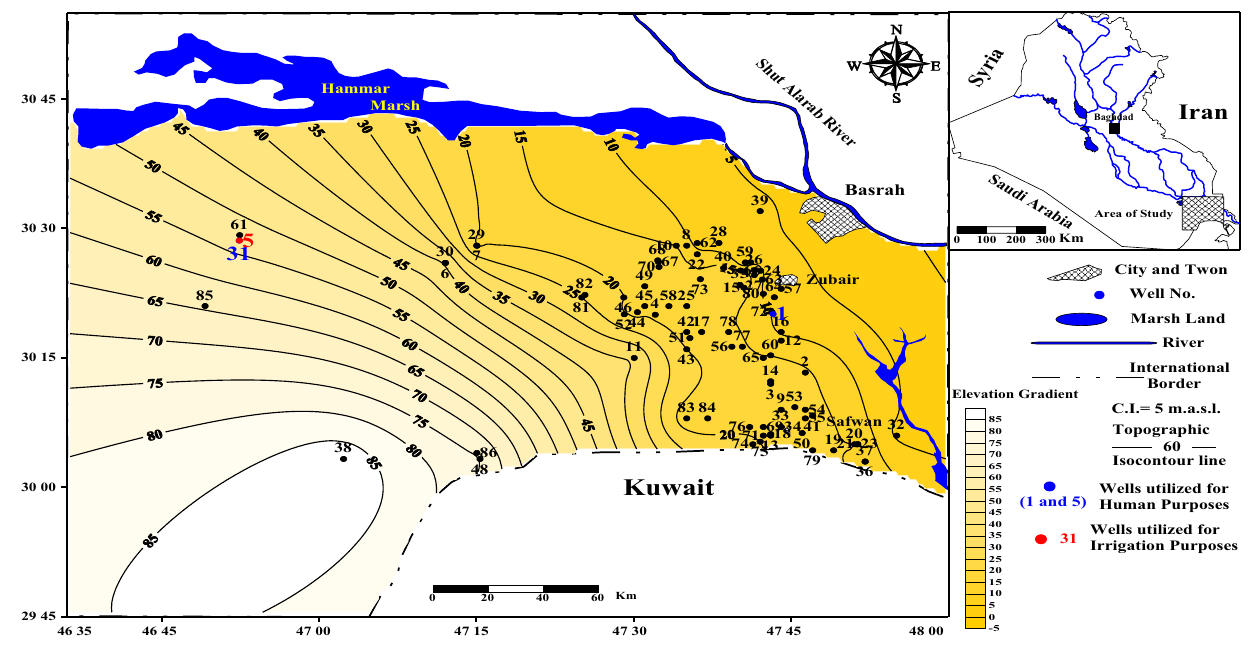
Fig. 1 Topographic and groundwater wells location map in studied